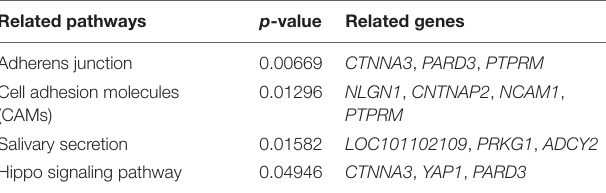
TABLE 1 | Four significantly enriched KEGG